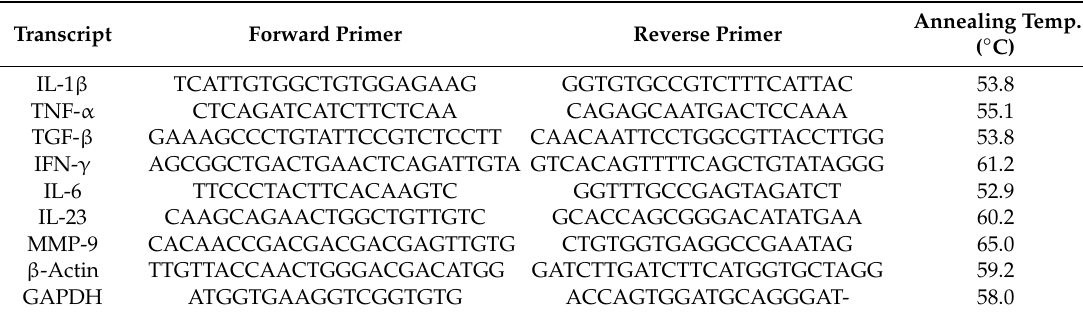
Table 2. RT-qPCR primer sequences (5 (cid:48) to 3 (cid:48)